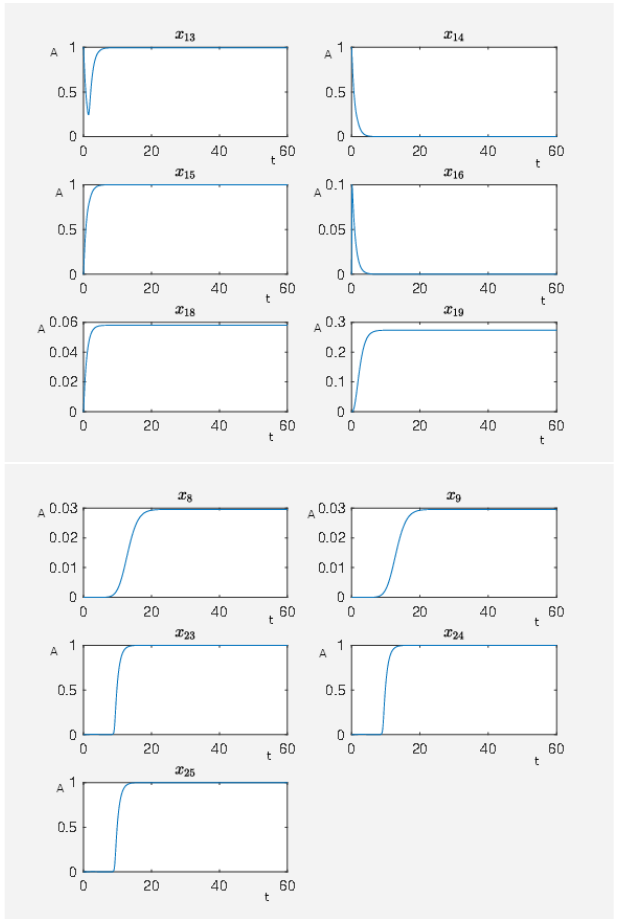
Figure 8. On the abscissa, we have the time (t) and on the ordinate the activity level (A) for PKC (node 13), RKIP (node 14), RKIP dim (node 15), GRK2 (node 16), isoproterenol (node 18), G s -coupled β 1 receptor (node 19), p90RSK (node 8), p70S6K (node 9), Elk1 (node 23), MSK1 (node 24), and c-Myc (node